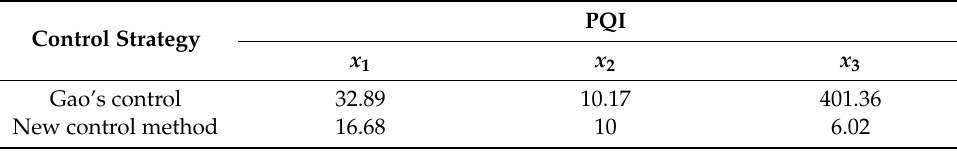
Table 1. Performance Quality